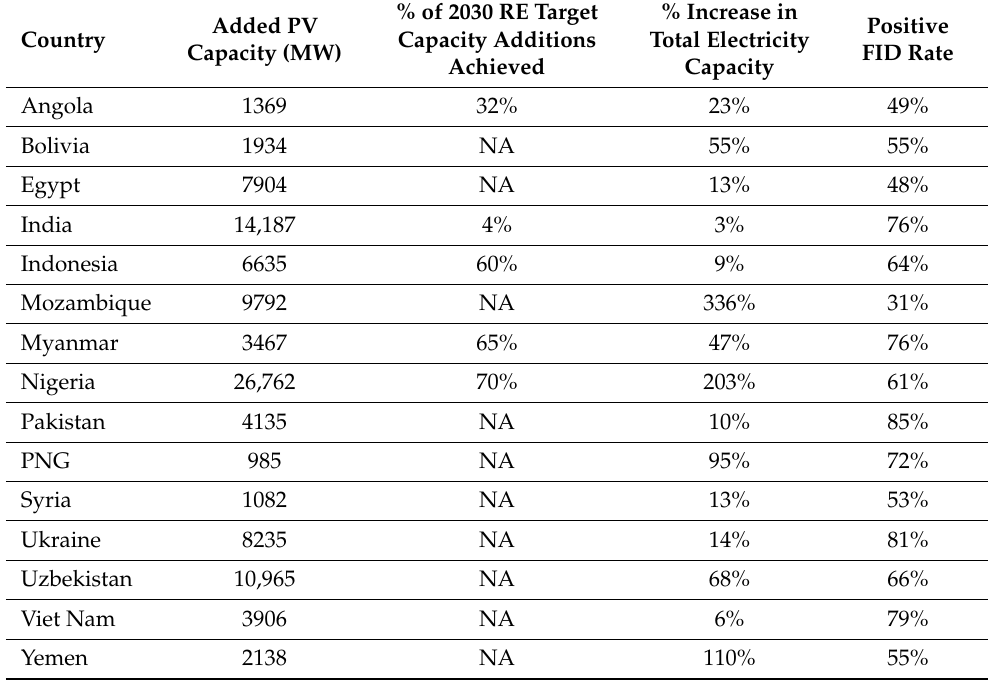
Table 4. Simulation results for added PV capacity and upstream investment success rate by country. Added Country